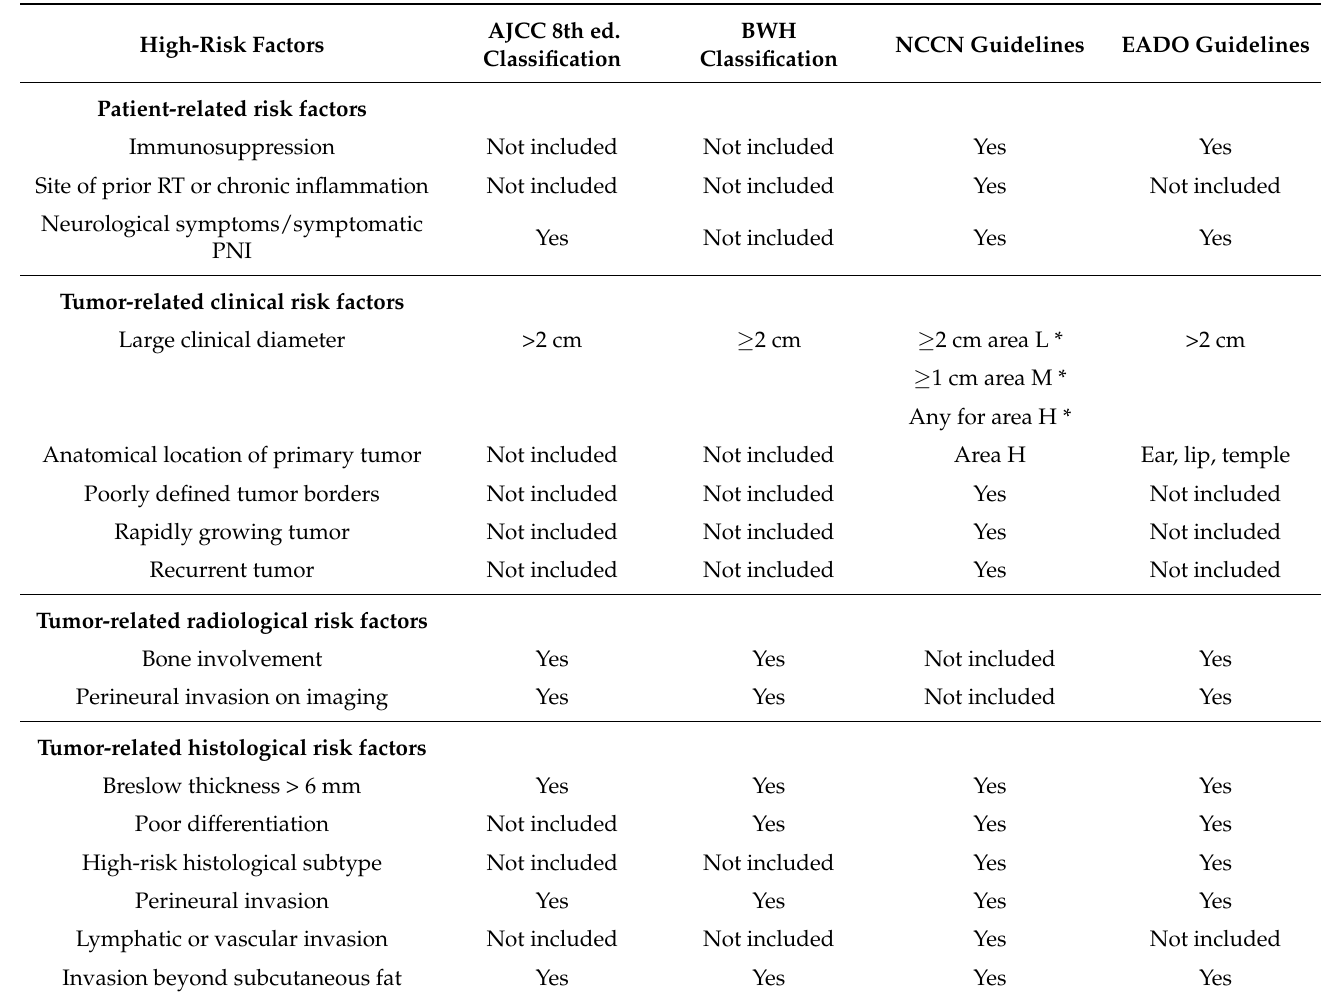
Table 3. Summary of high-risk factors for primary squamous cell carcinoma according to recent staging systems and